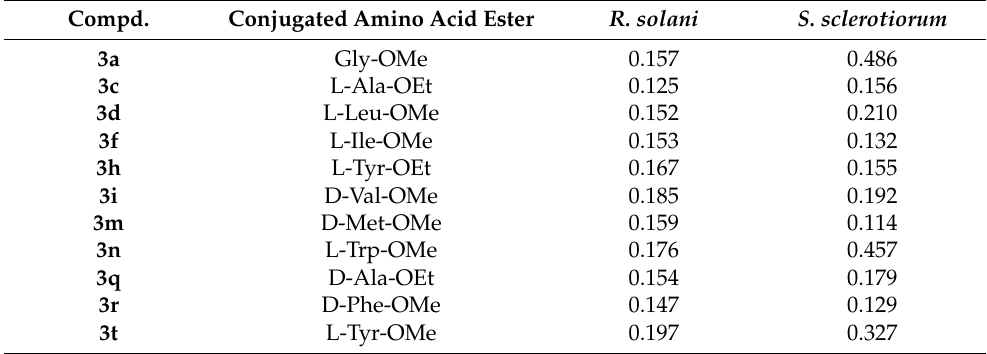
Table 1. EC 50 values of effective compounds against R. solani and S. sclerotiorum in vitro (mM).